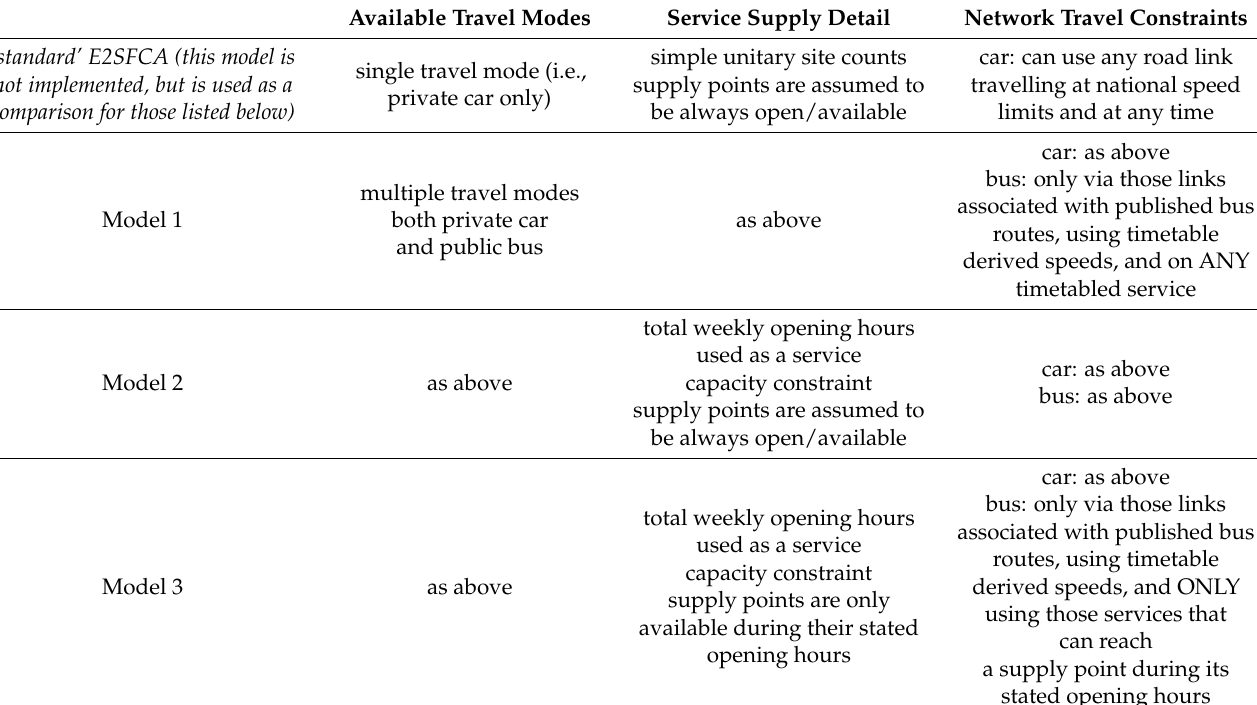
Table 1. A typology of FCA models adopted in this study. Available Travel Modes Service Supply Detail Network Travel